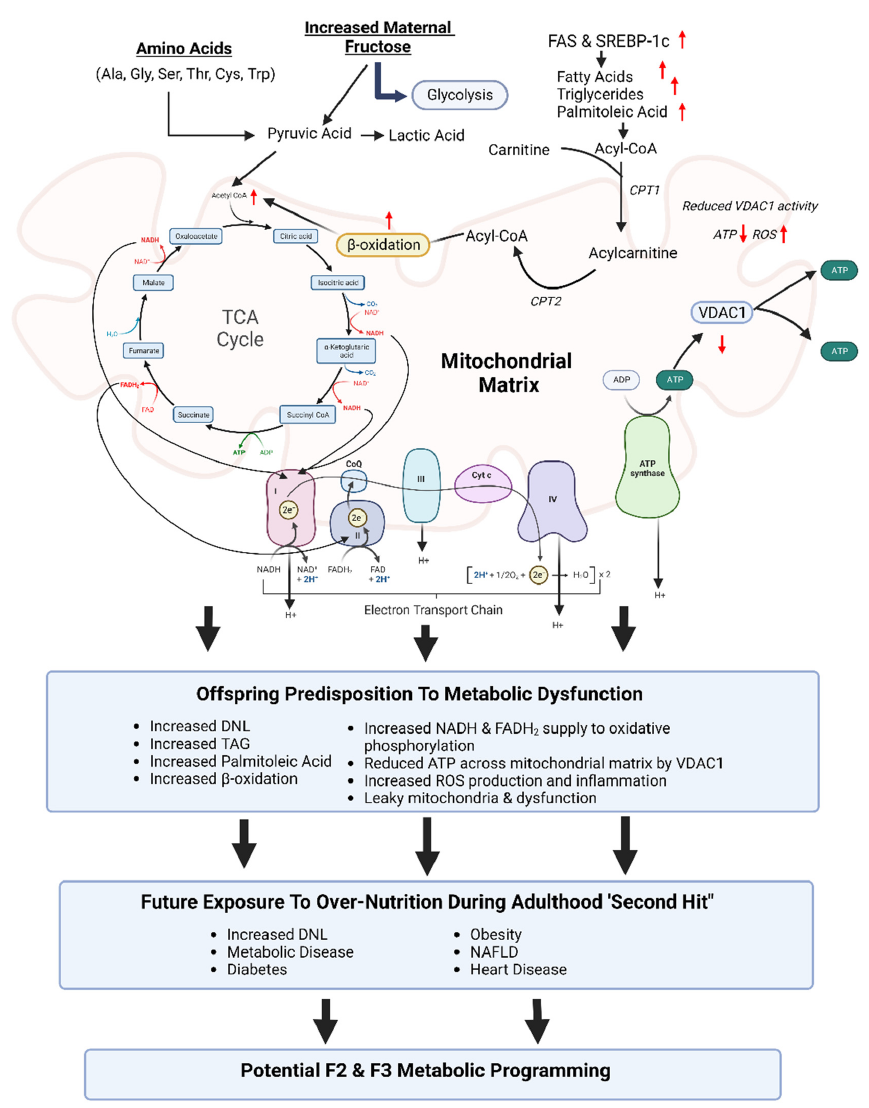
Figure 4. Proposed developmentally programmed mechanisms of long-term mitochondrial function, following excess maternal fructose intake. Red arrows indicates offspring metabolic alterations due to excess maternal fructose intake, and the proposed developmentally programmed mechanisms of long-term mitochondrial function and subsequent predisposition to metabolic dysfunction. Following exposure to a ‘second hit’ of over-nutrition during adulthood, this increases the risk of experiencing metabolic disease(s). These programmed mitochondrial effects in F1 may affect germline modifications of F1 foetal gametes, potentially programming F2 and F3 metabolic function. Diagram created with BioRender.com, accessed on 27 September